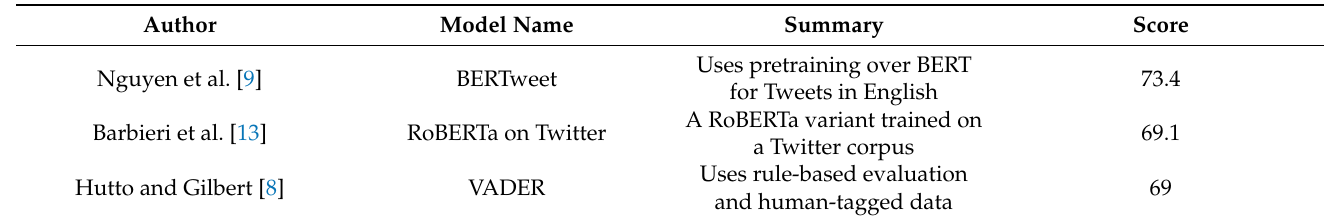
Table 1. Summary of different popular language models evaluated using a sentiment analysis corpus [15]. The evaluation of VADER was performed